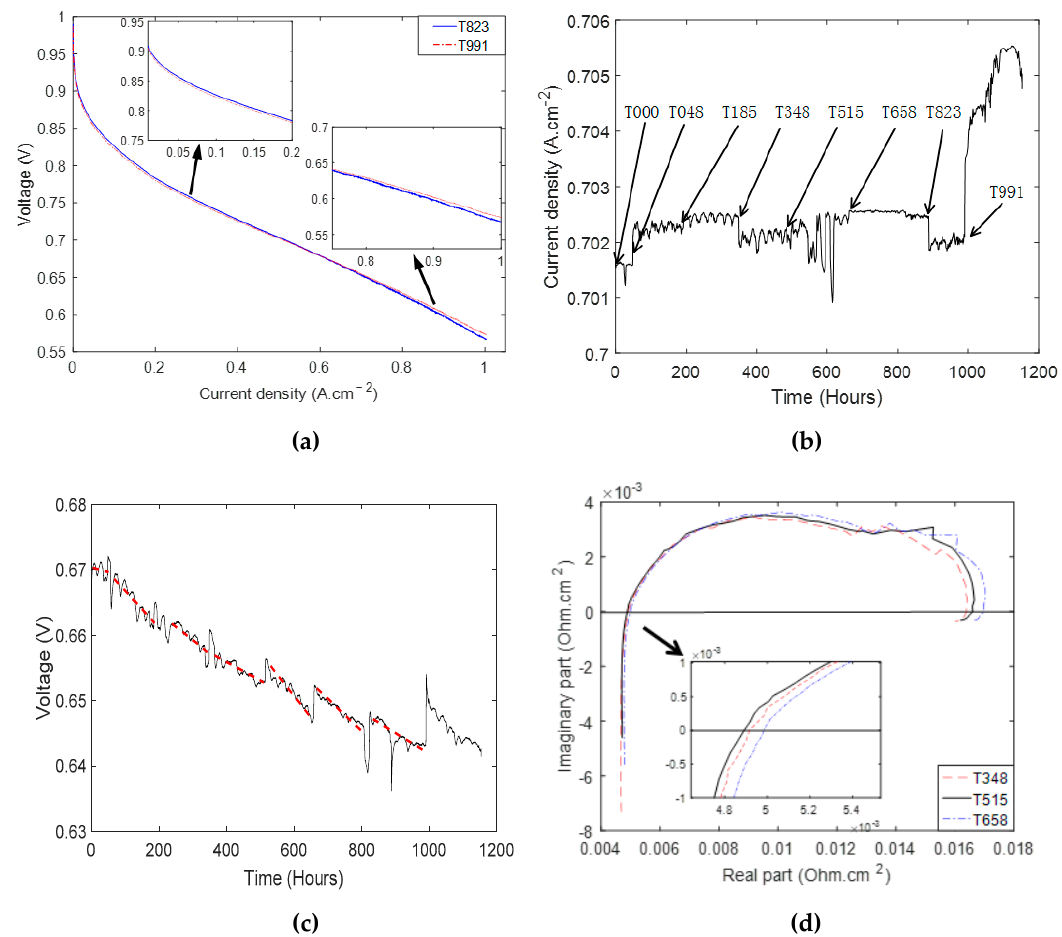
Figure 6. Tested PEMFC performance during the test. ( a ) Collected V-I curves at 823 h and 991 h; ( b ) Current density evolution; ( c ) Average cell voltage evolution; ( d ) Collected EIS at 348 h, 515 h and 658 h. Table 8. PEMFC degradation rate at different time intervals during the tests.